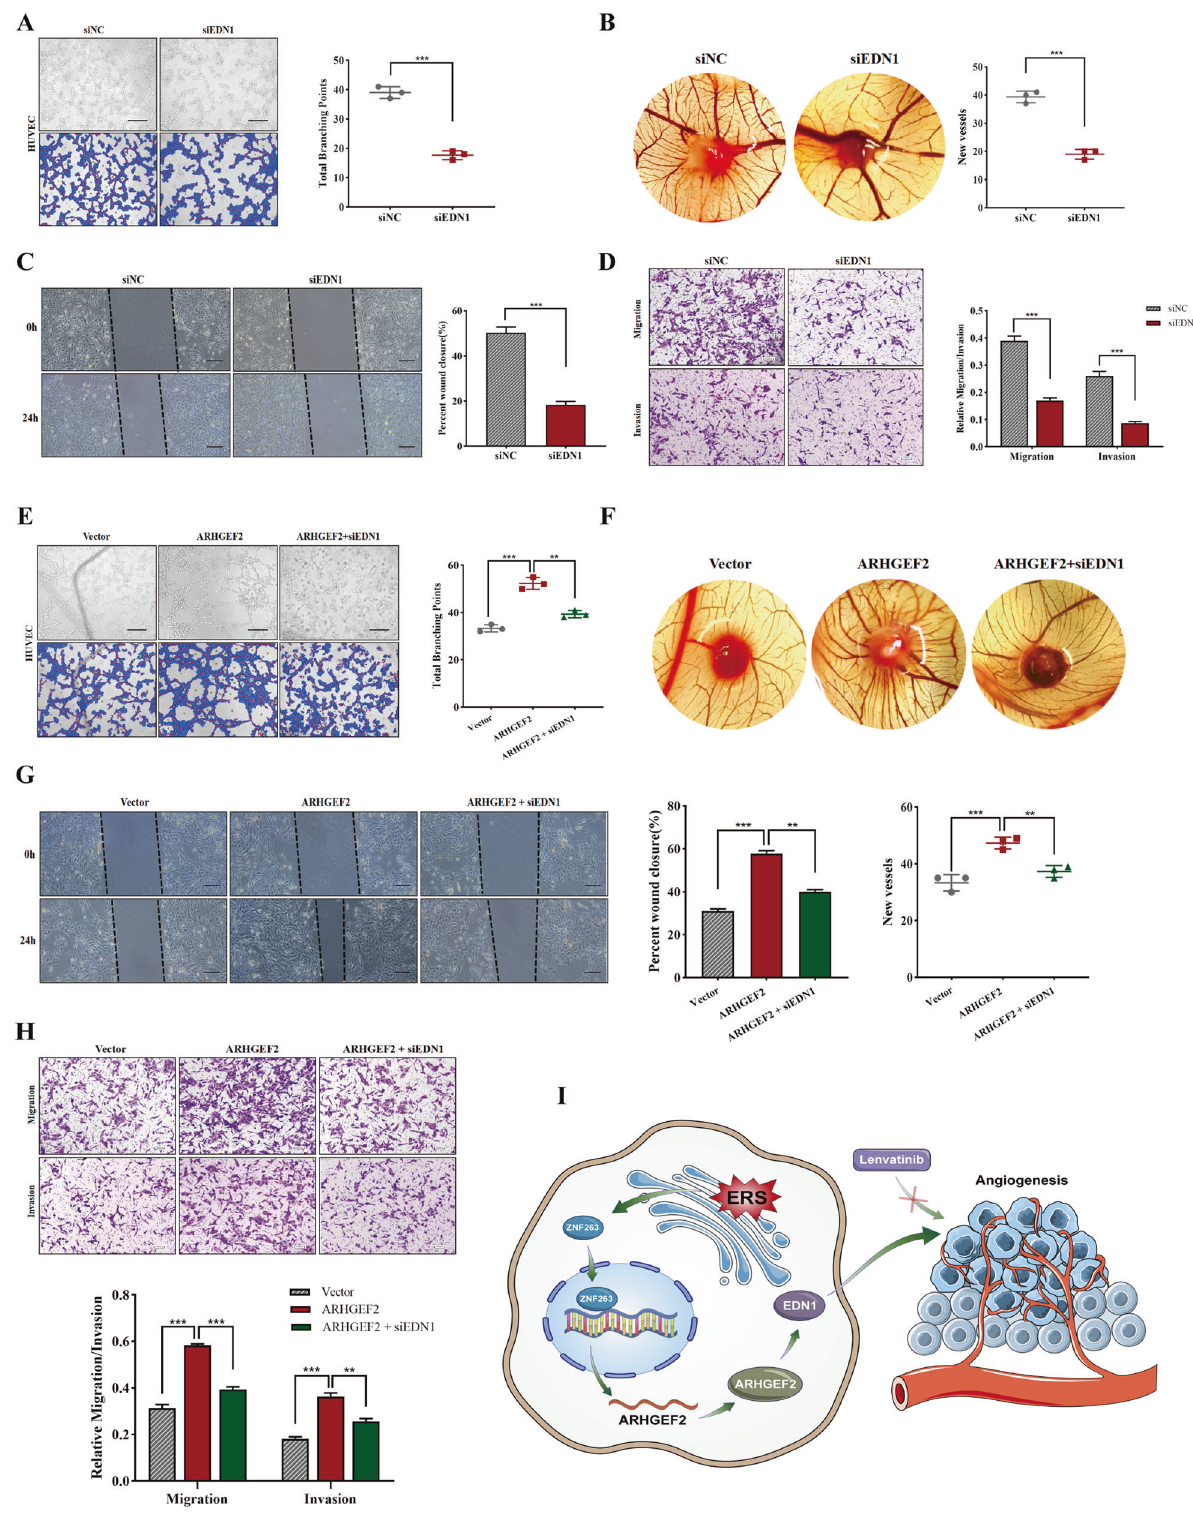
Fig. 8 ARHGEF2 exerted an angiogenic effect via EDN1. A – D The cell-conditioned media of HepG2/siNC and HepG2/siEDN1 cells were collected for the tube formation assay ( A ), the CAM assay ( B ), the wound-healing ( C ) and the transwell assay ( D ). E – H EDN1 was knocked down in ARHGEF2 stable-overexpressing cell lines, and the CM was collected for the tube formation assay ( E ), the CAM assay ( F ), the wound-healing assay ( G ) and the transwell assay ( H ). I Schematic illustration of ER stress upregulates ZNF263/ARHGEF2/EDN1 signaling pathway to promotes angiogenesis and antagonizes the sensitivity of lenvatinib to HCC